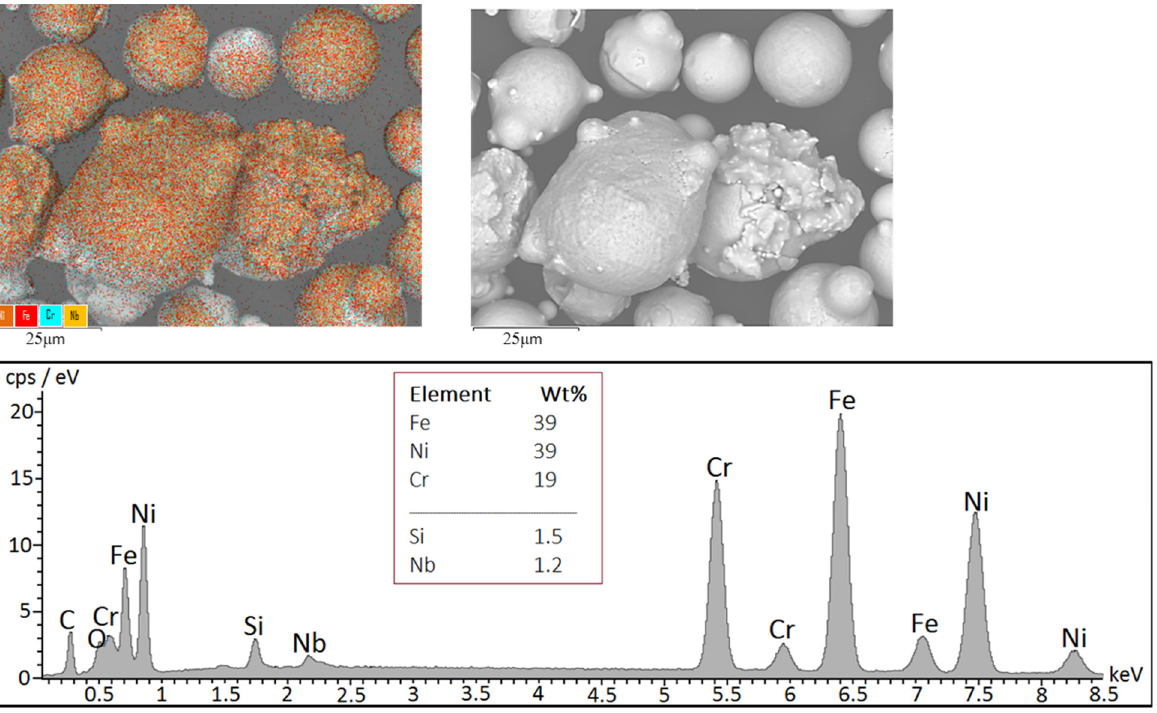
Figure 2. Elemental mapping of particle surfaces ( left ) in FRESH sample, electron image of particles in BSE mode ( right ) and characteristic X-ray spectrum with the evaluation of main elements.